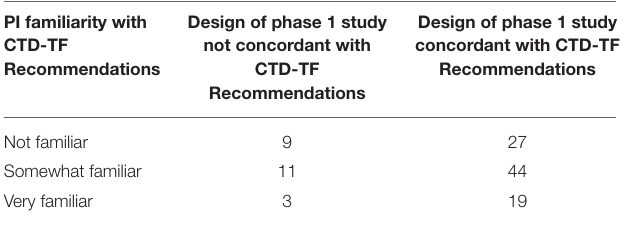
TABLE 3 | Familiarity of the Principal Investigator (PI) with Clinical Trial Design Task Force (CTD-TF) recommendations vs. concordance between the study design used in the phase 1 trial and CTD-TF recommendations.